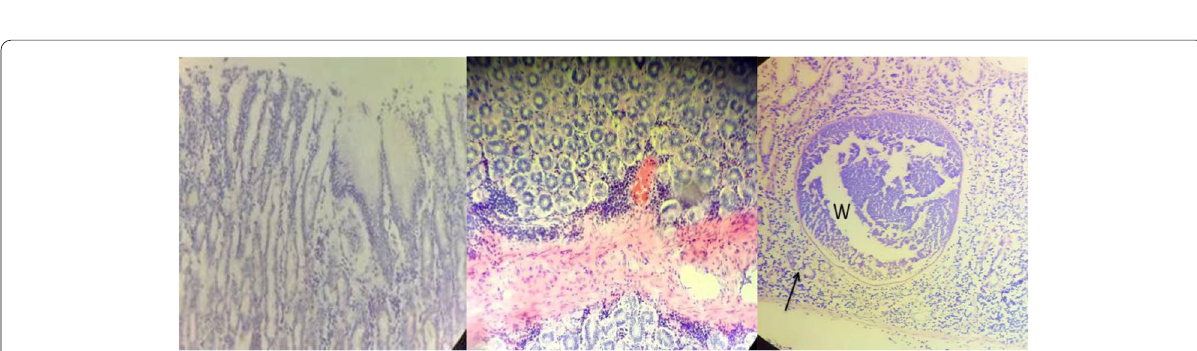
Fig. 9 Histopathological changes in the abomasal fundus of H. contortus infected goat under low magnification (10x): (A) denuded surface epithelium with damaged gastric pits, (B) high cellular infiltration and hemorrhagic submucosa, (C) tissue doweling worm section (W) surrounded by cellular infiltration (arrow); (HE staining); Where A, B and C are from left to right right